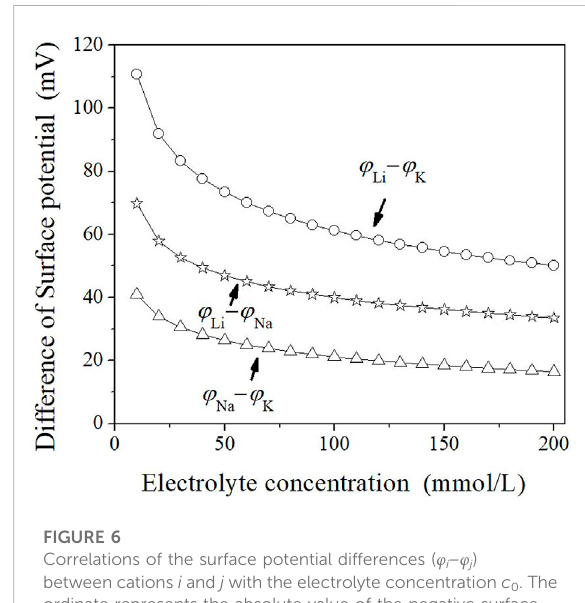
FIGURE 6 Correlations of the surface potential differences ( φ i − φ j ) between cations i and j with the electrolyte concentration c 0 . The ordinate represents the absolute value of the negative surface